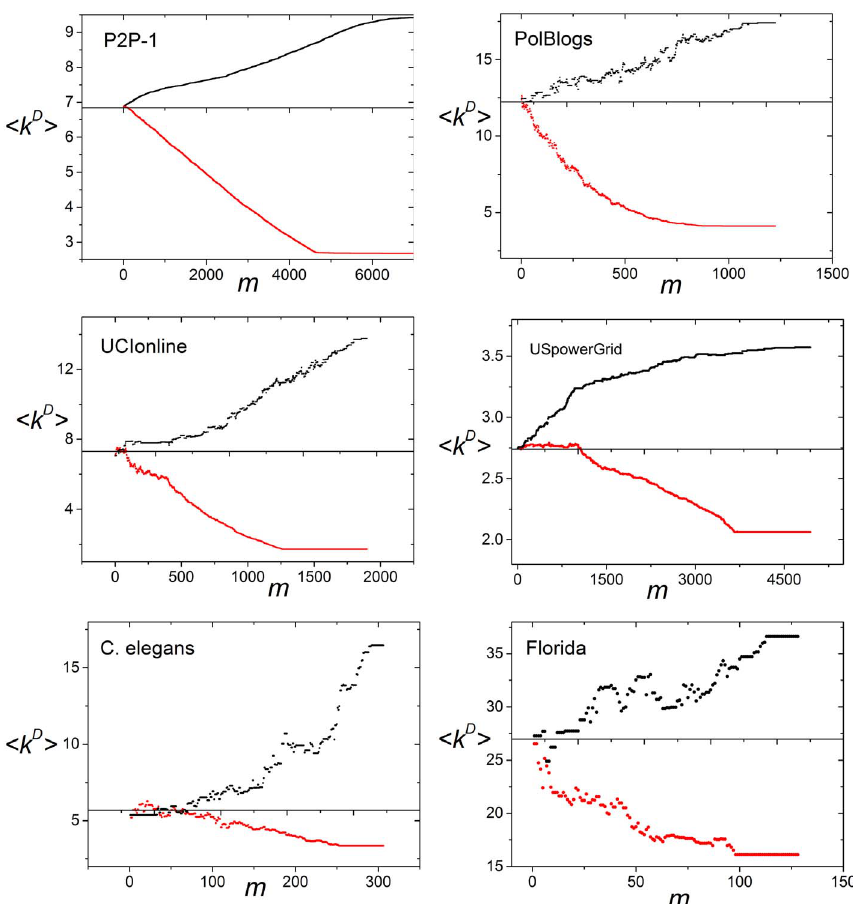
Figure 2. Relationship of , k D . of a MDS versus the preferential matching number m . The results above the solid line show the value of , k D . when nodes are sorted in ascending order by degree. The results below the solid line show the value of , k D . when nodes are sorted in descending order by degree.